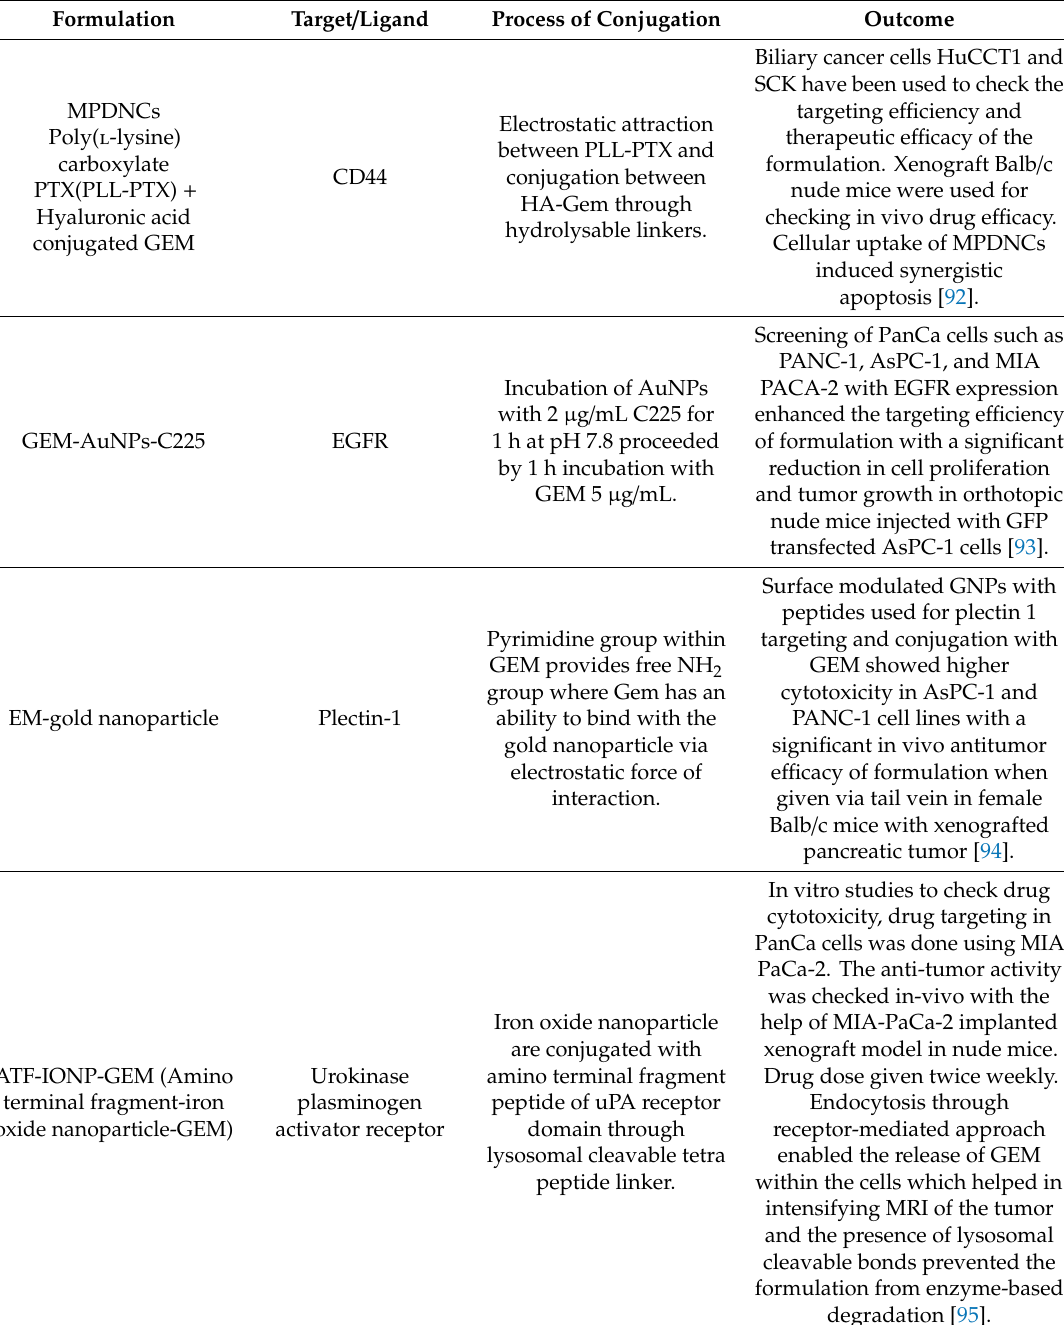
Table 2. Receptor-based targeting of Gemcitabine-based co-formulation designed using various